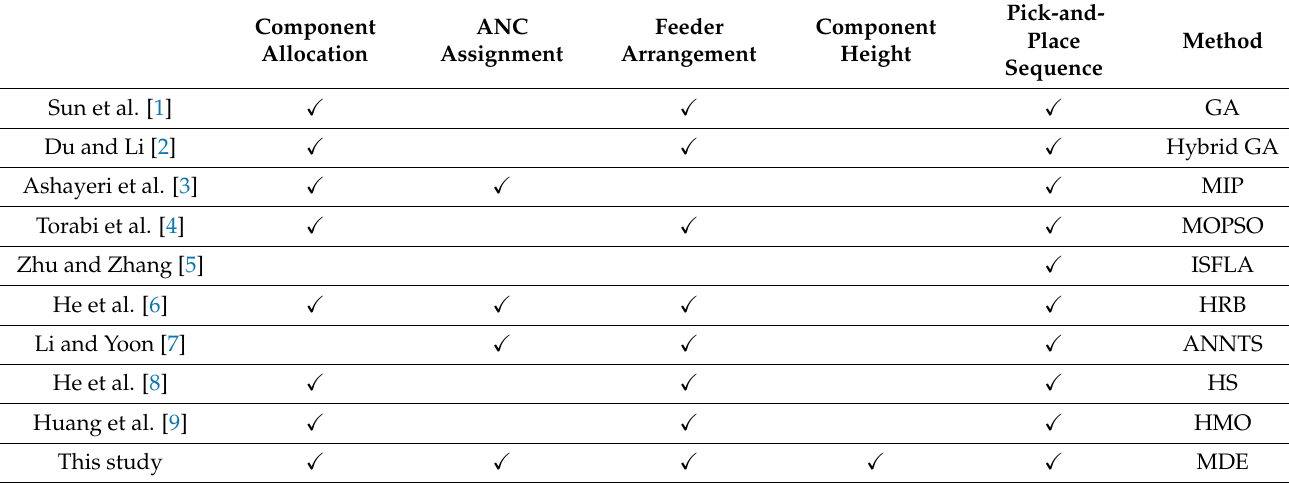
Table 1. Summary of the discussed problem in the related